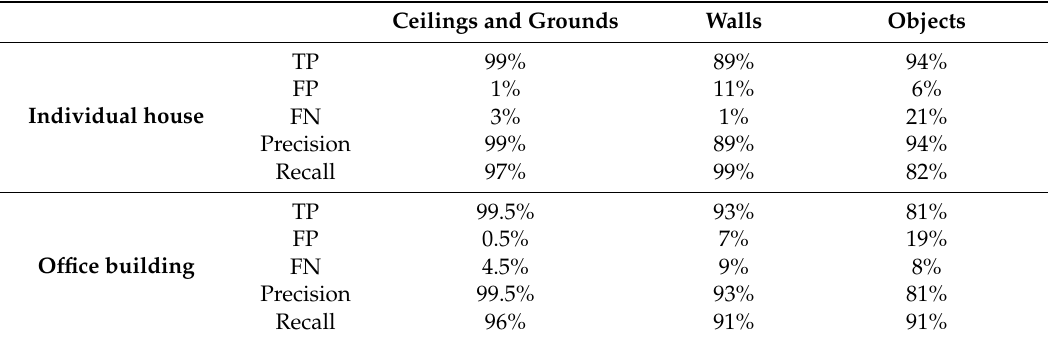
Table 3. Assessment of point classification into several